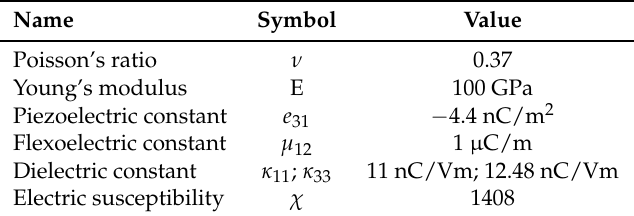
Table 1. Material